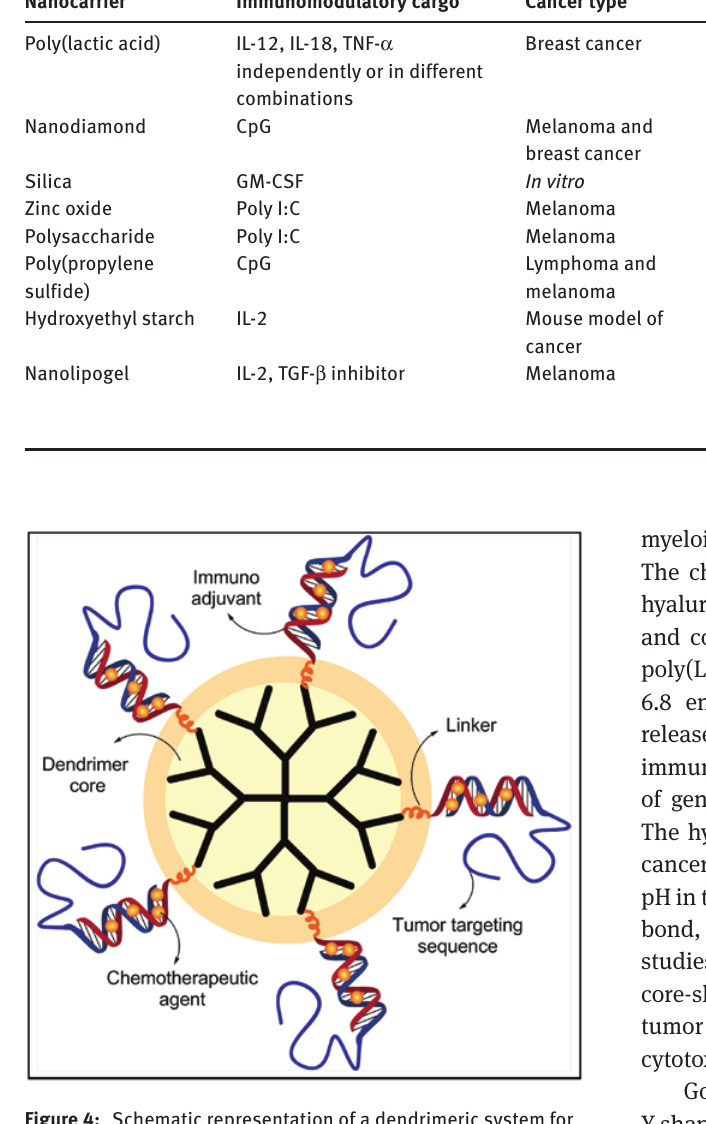
Figure 4: Schematic representation of a dendrimeric system for